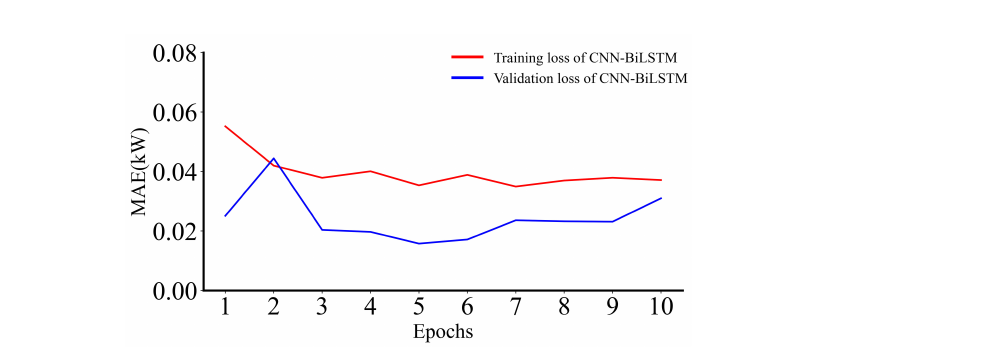
Figure 5. The training and validation losses of the CNN-BiLSTM model (the hybrid model).